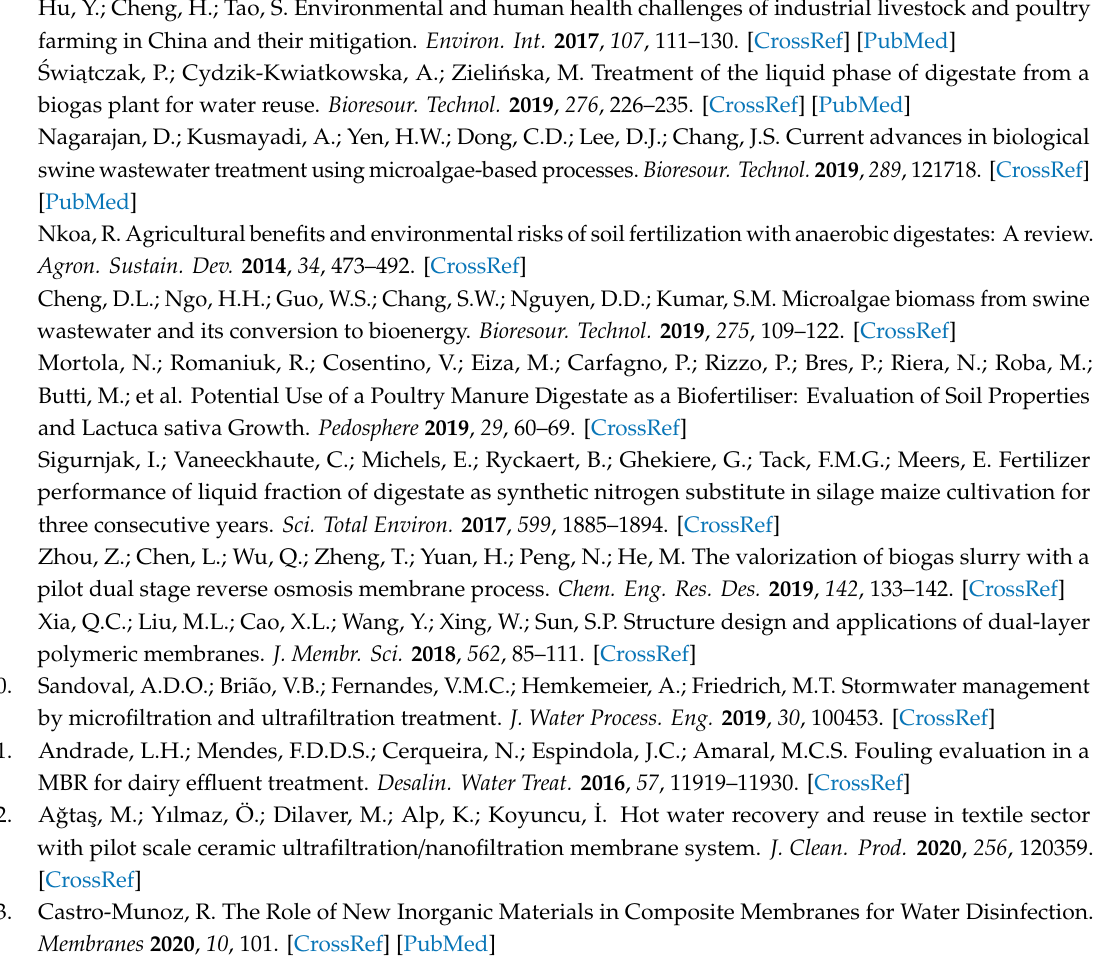
Table S1: The di ff erent batches of the biogas digestate from swine manure, Figure S1: The Rrs (%) of (a) physical and chemical parameters and (b) antibiotics content in RO permeates with HFUFM and CUFM pretreatment method. Figure S2: The content of (a) TN, (b) NH 4 + -N, (c) TP, (d) TK, (e) COD, (f) TOC in the concentrates of the integrated process with HFUFM and CUFM pretreatments. Figure S3: The content of (a) sulfadimethylpyrimidine, (b) enrofloxacin and ciprofloxacin, (c) oxytetracycline, (d) doxycycline in the concentrates of the integrated process with HFUFM and CUFM